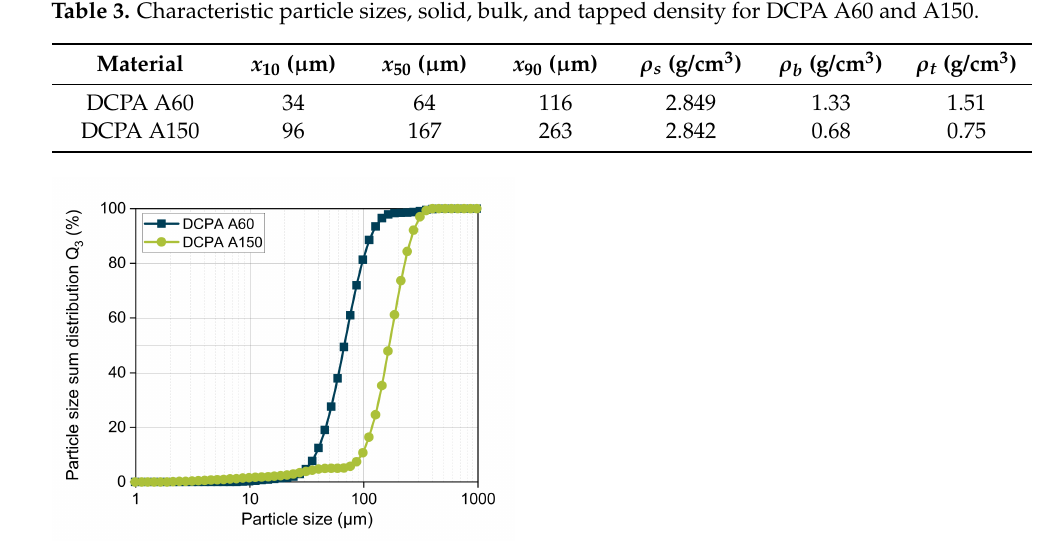
Figure 8. Particle size distribution of the